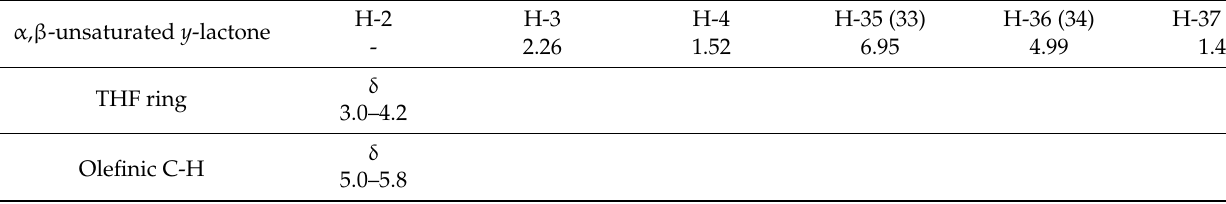
Figure 4. 1 H NMR spectrum of FDSAM. Source: Authors. Table 1. Values of chemical shifts δ characteristics of